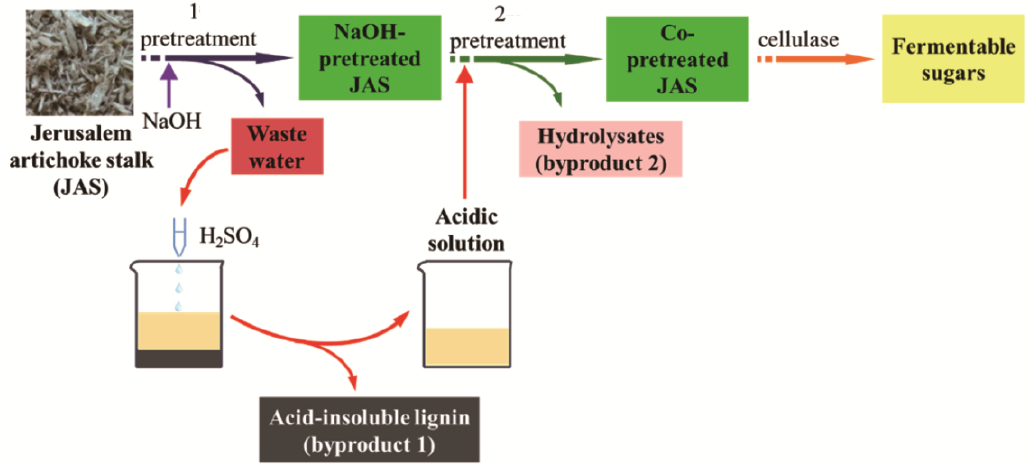
Figure 1. Schematic presentation of the designed pretreatment